Question: How would you classify this visualization?
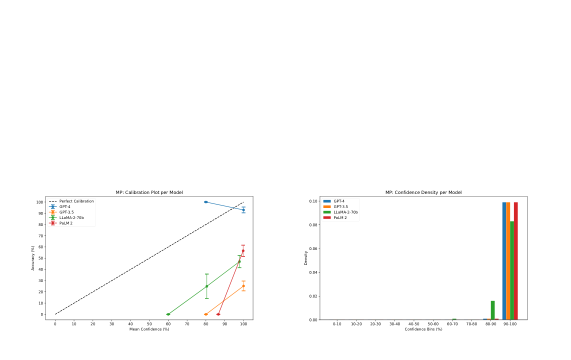
Answer: histogram